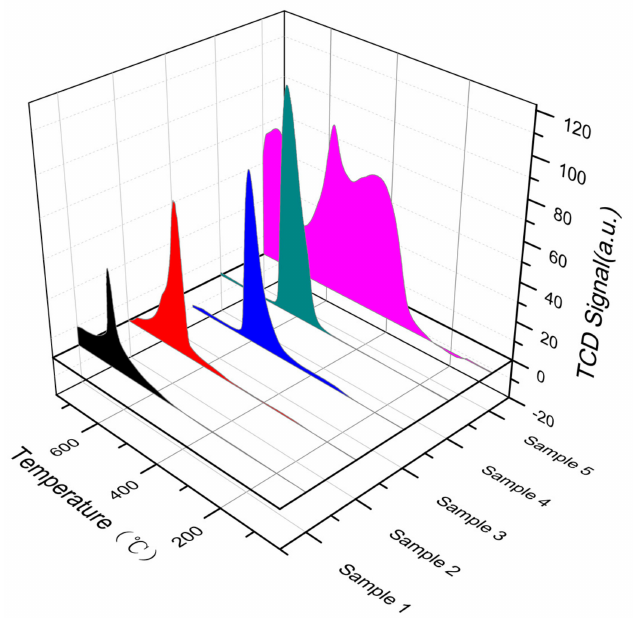
Figure 6. Adsorption characteristics of NO in samples subjected to di ff erent treatment